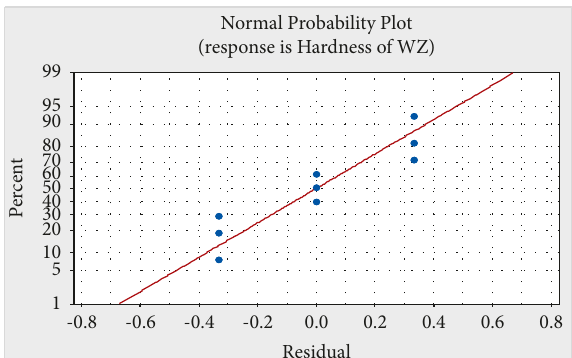
Figure 7: Normal probability plot of residual for hardness of weld zone.